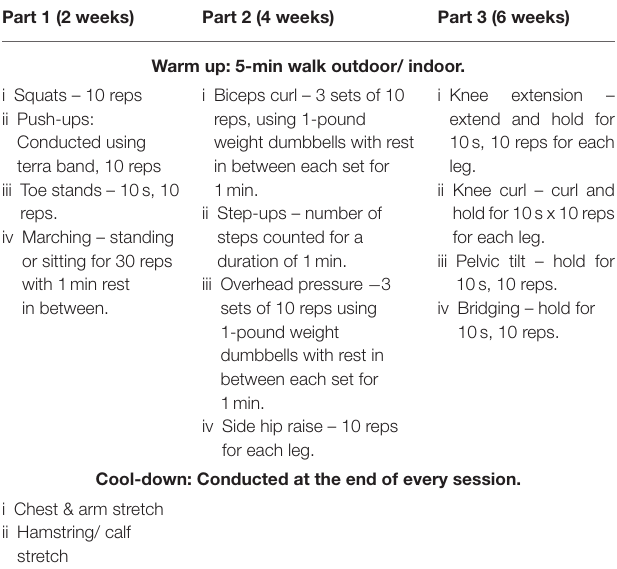
TABLE 1 | Detailed exercise for part 1, part 2 and part 3 of COME